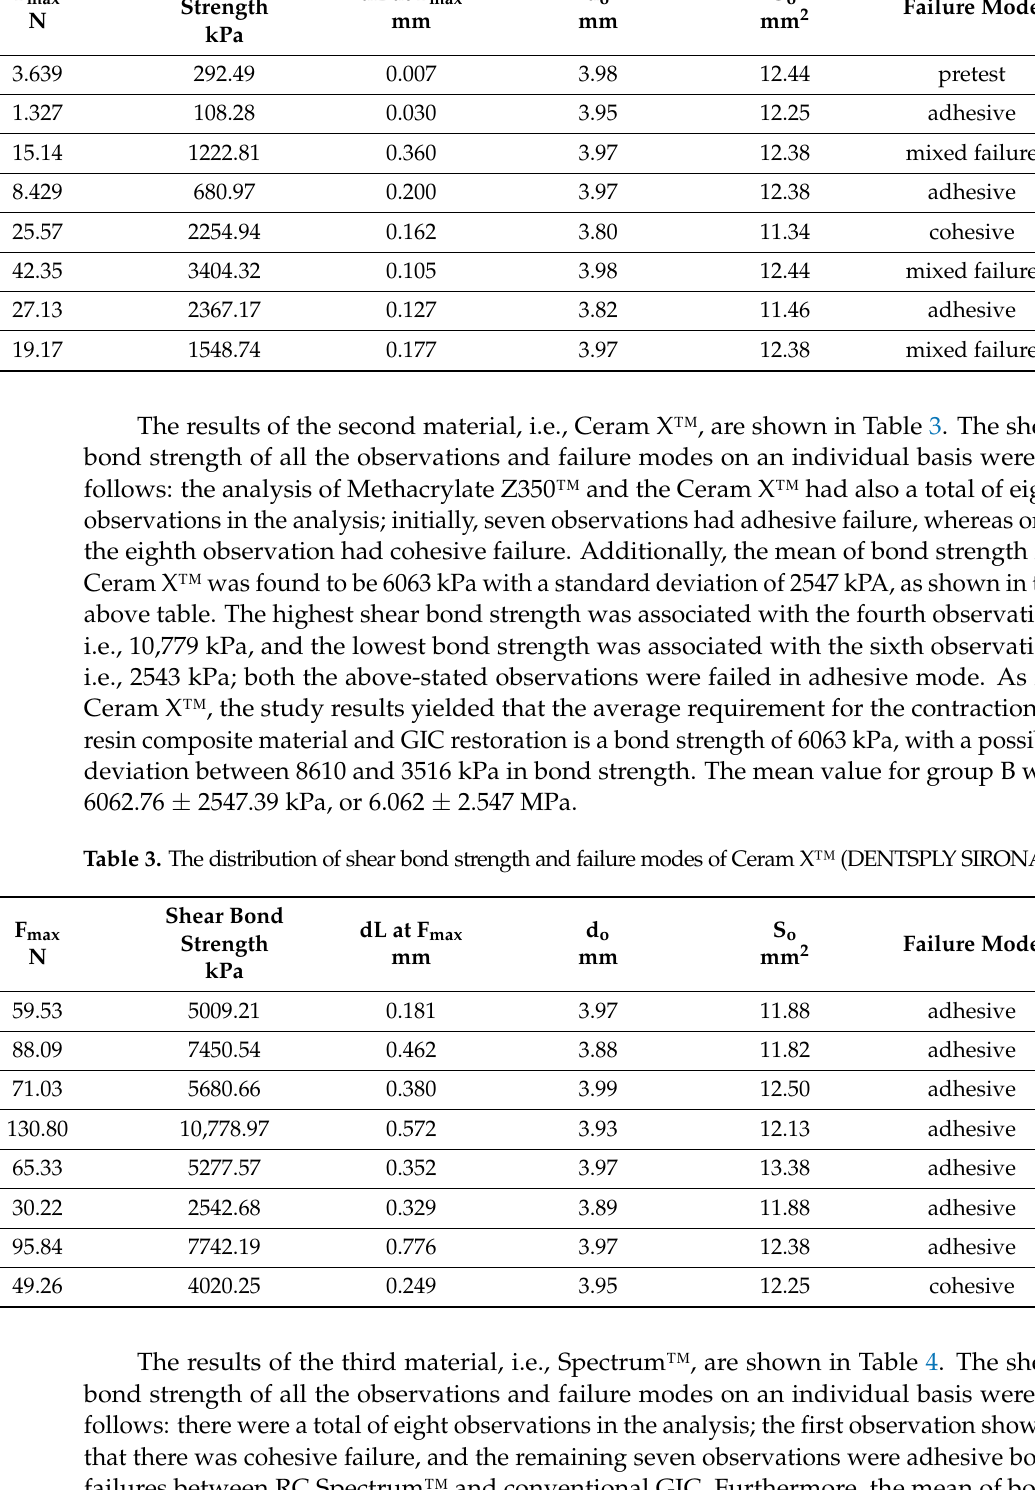
Table 2. The distribution of shear bond strength and failure modes for Methacrylate Z350™ (3M ESPE). Material A